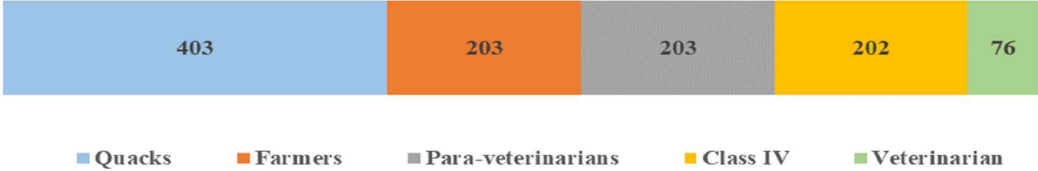
Figure 5. Personnel responsible for irrational use of antibiotics in field *. (Quacks: unauthorized practitioners; Para- veterinarians: diploma holders in Veterinary Science, Class IV: helping staff in veterinary hospitals) (* Question: Whom do you think as responsible for the irrational use of antibiotic in bovines at the field level (select all that apply)? (The question was having the provision to select more than one